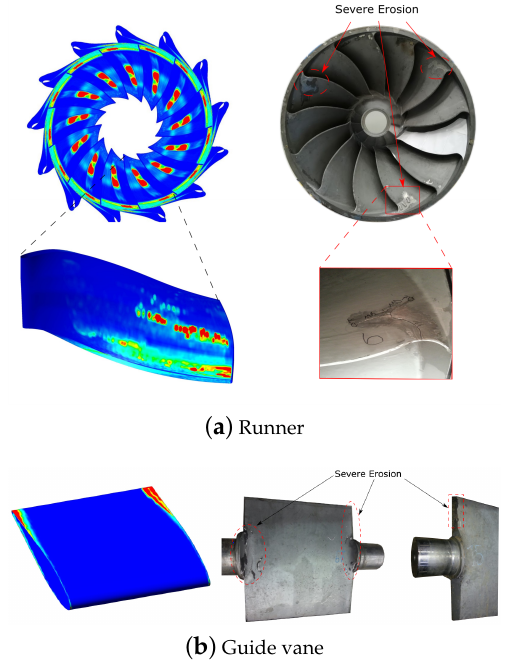
Figure 12. Erosion profiles in turbine